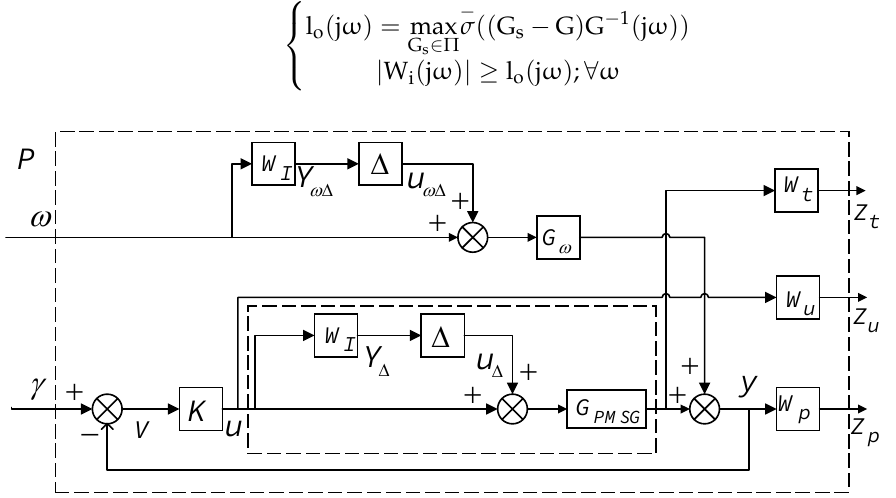
Figure 18. Structural block diagram of uncertain systems of a PMSG-based wind farm.